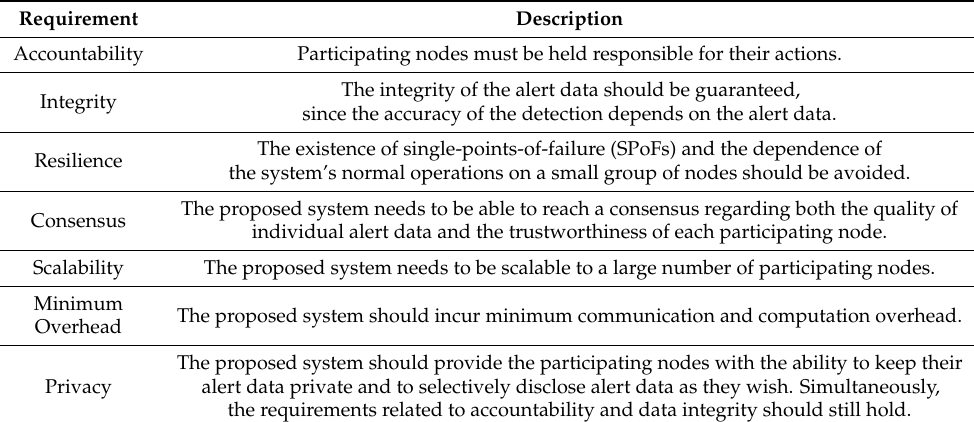
Table 4. Requirements for the design of an effective and trustworthy CIDS mentioned in [54]. Requirement